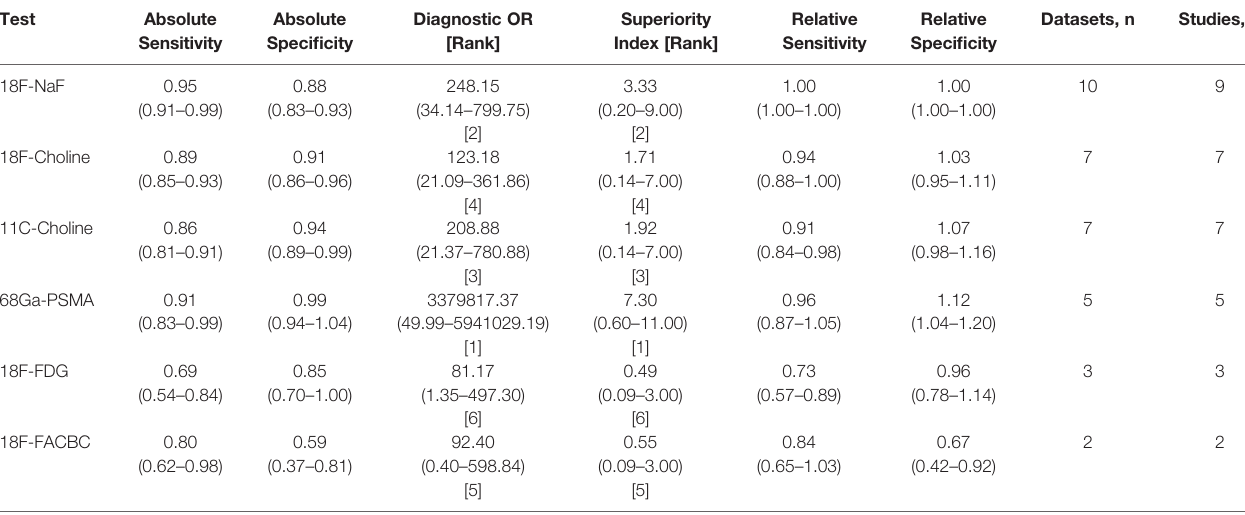
TABLE 2 | The network meta-analysis results of PET/CT with different tracers to detect bone metastasis in PCa. Test Absolute